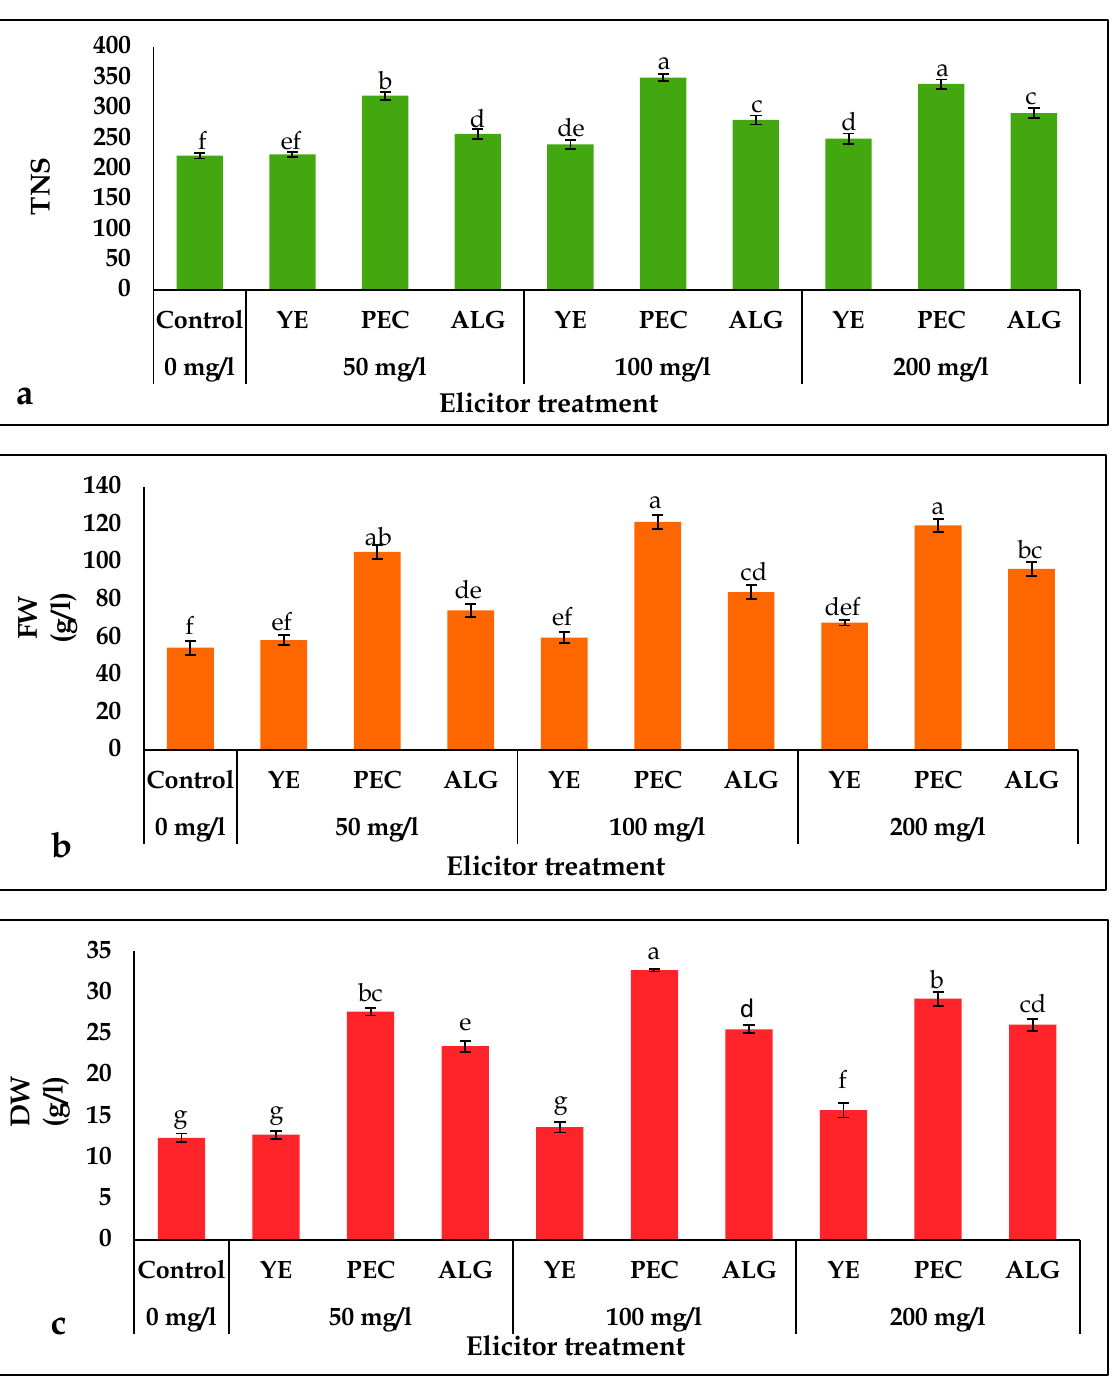
Figure 1. Effect of elicitor treatments on morphological attributes in in vitro shoots of P. tuberosa : ( a ) TNS, ( b ) FW (g/L), ( c ) DW (g/L). Values are mean ± SD, means in a column followed by different letters are significantly different from each other at p < 0.05. Mean values followed by the same letter(s) in a column are not significantly different ( p < 0.05) based on Duncan multiple range test